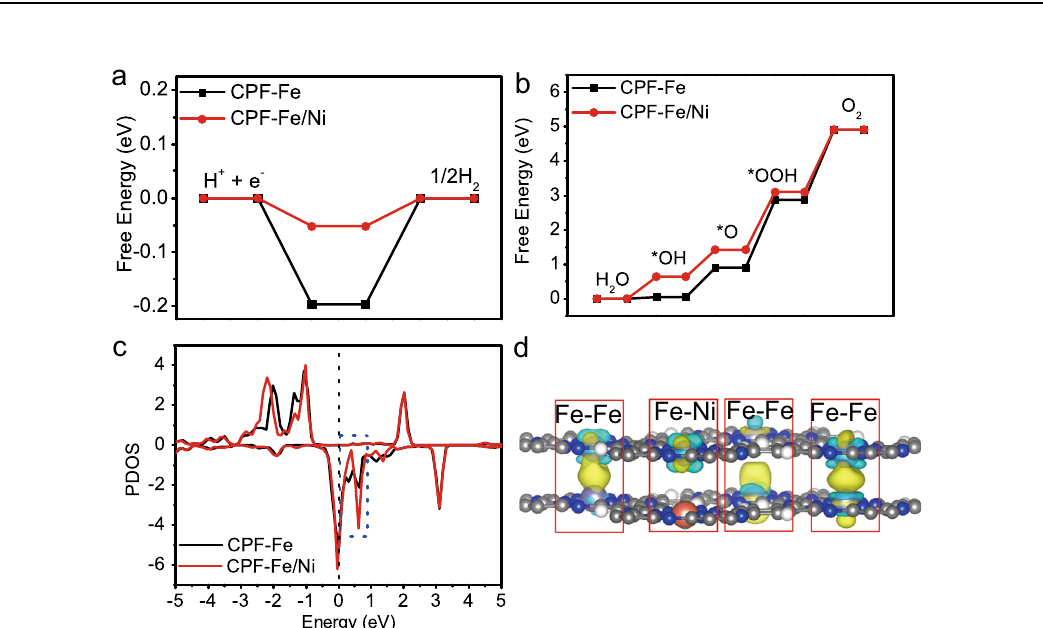
yellow and blue area denote the electron accumulation and loss. The isosurface is 0.002 e/Å 3 .